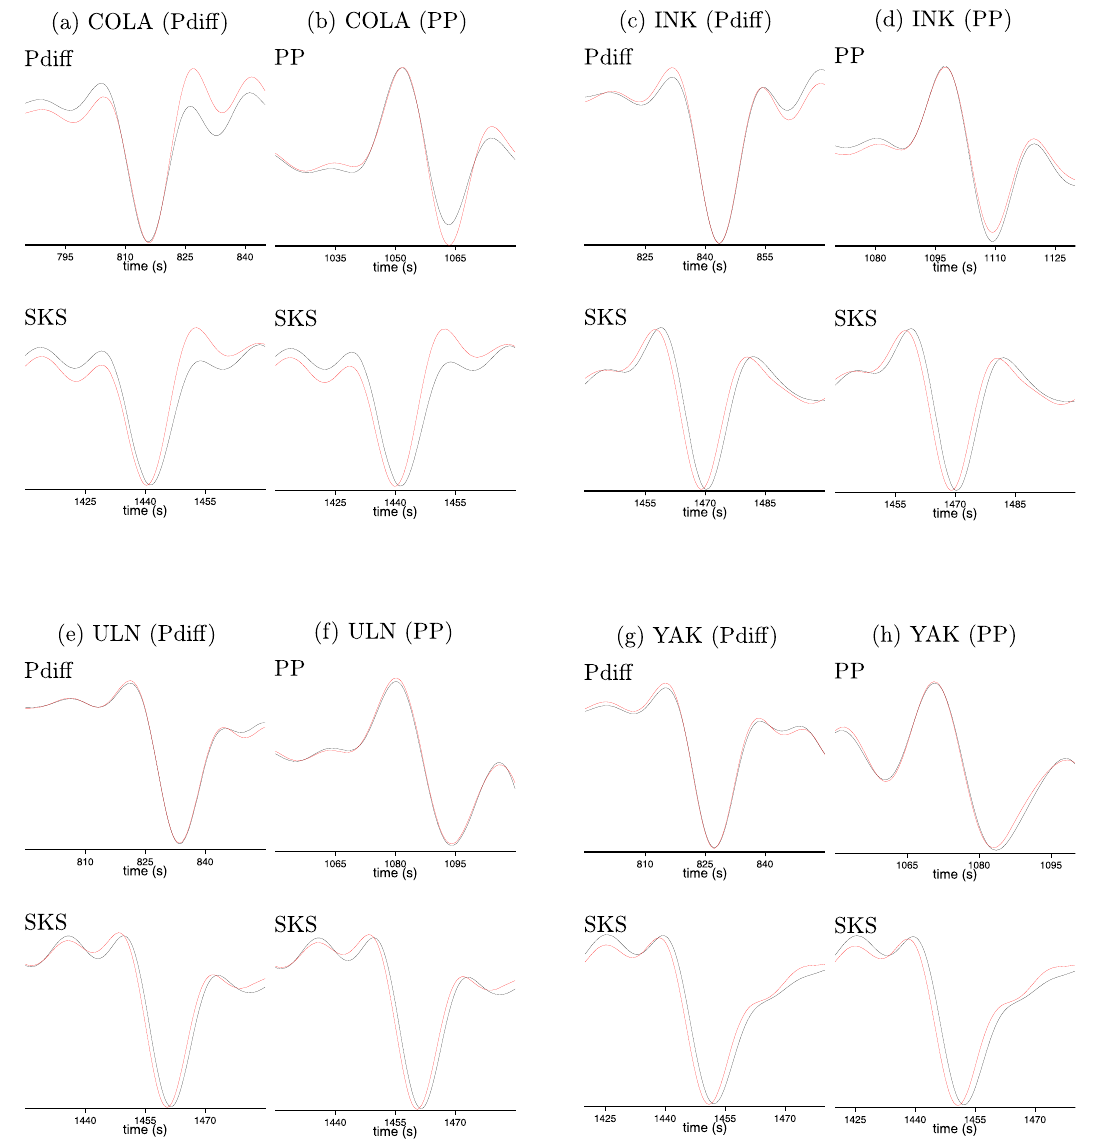
Fig. 3 Early arrivals of SKS waves from the second earthquake. a – h Seismograms showing the early arrivals of the core-penetrating SKS waves from the second earthquake when PP and Pdiff waves from the earthquake pair (P16) are aligned. The differential travel times between PP and Pdiff waves are small, with δ t PP − δ t Pdiff being 0.4 s at COLA, 0.1 s at INK, 0.1 s at ULN, and 0.35 s at YAK. This indicates that their distances to the two earthquake epicenters are very